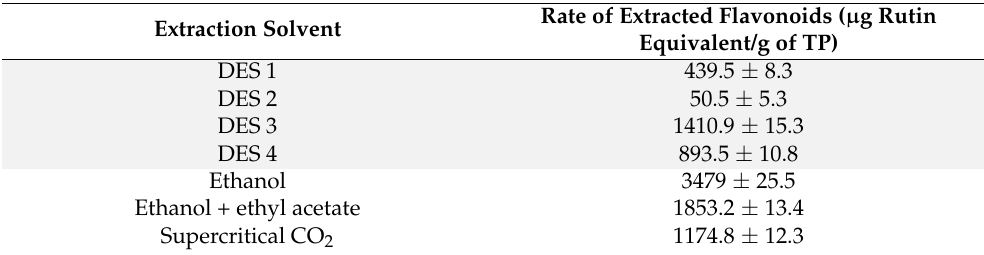
Table 6. Comparison of extracted flavonoid rates from tomato pomace.